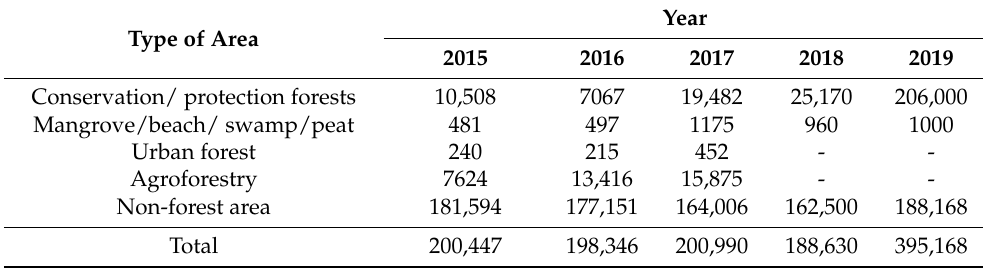
Table 4. Area planted in forest and non-forest area (in ha).